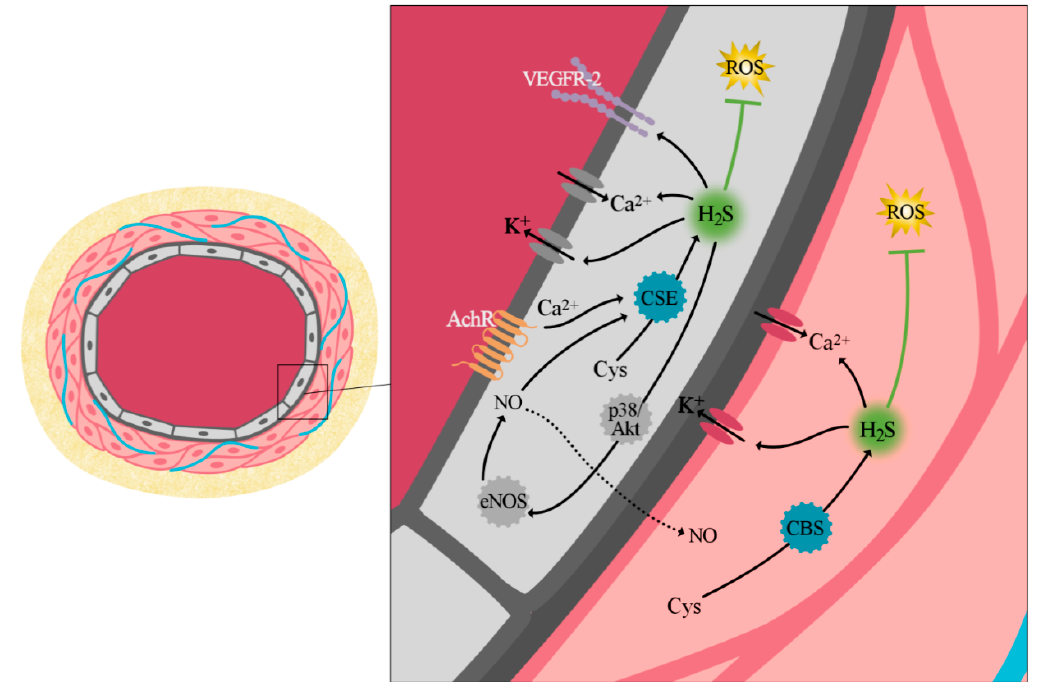
Figure 2. Physiological effects of intracellular hydrogen sulfide production in vascular smooth muscle cells and endothelial cells. Vascular endothelial growth factor receptor 2 (VEGFR-2); Acetylcholine receptor (AchR); Cysteine (Cys); endothelial nitric oxide synthases (eNOS); black solid arrows represent a direct effect, the black dotted arrows represent a direct effect on a different cell, and the green T-bar represents the inhibitory effect of hydrogen sulfide.